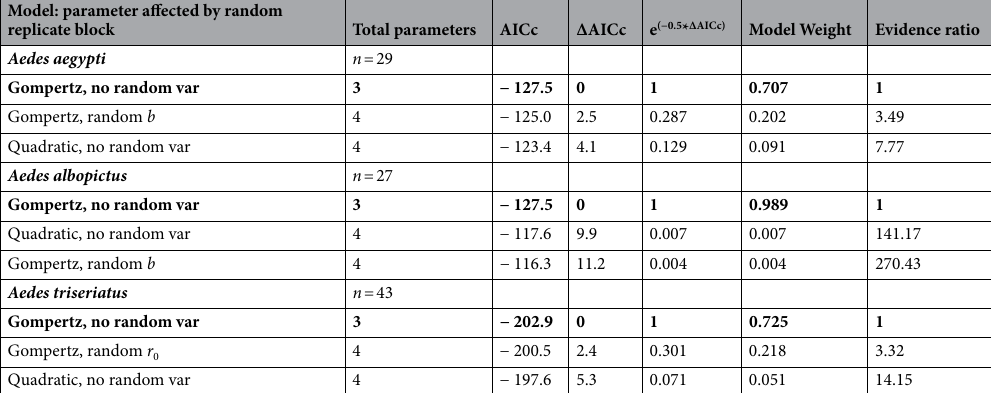
Table 1. AICc values comparing the top three models of r’ vs. initial density N for Aedes aegypti, Aedes albopictus, and Aedes triseriatus. Models that failed to converge excluded, and those beyond the top three are included in the supplemental material (Table S2). For each species the best model is highlighted in bold face type. Functions given in Supplemental Table S4. Within the table ΔAICc is the difference between AICc on the current line and AICc for the top line (i.e., the most plausible model).